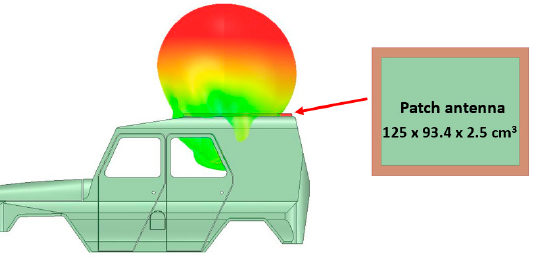
Figure 2. A simulated 3D radiation pattern of a rectangular patch antenna on a vehicle’s roof.